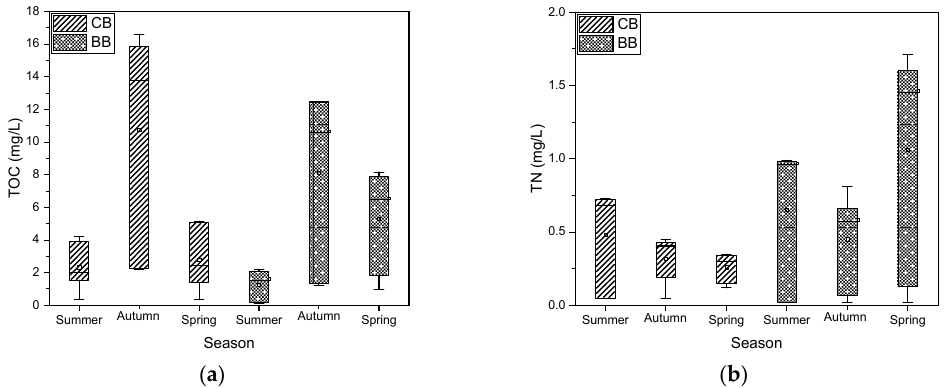
Figure 4. ( a ) TOC, and ( b ) TN concentrations of processed samples before disinfection, corresponding to sample site and season. Plots based off of all TOC and TN concentrations regardless of where the sample was collected from the treatment system. CB = Cork Brook, BB = Bailey Brook.